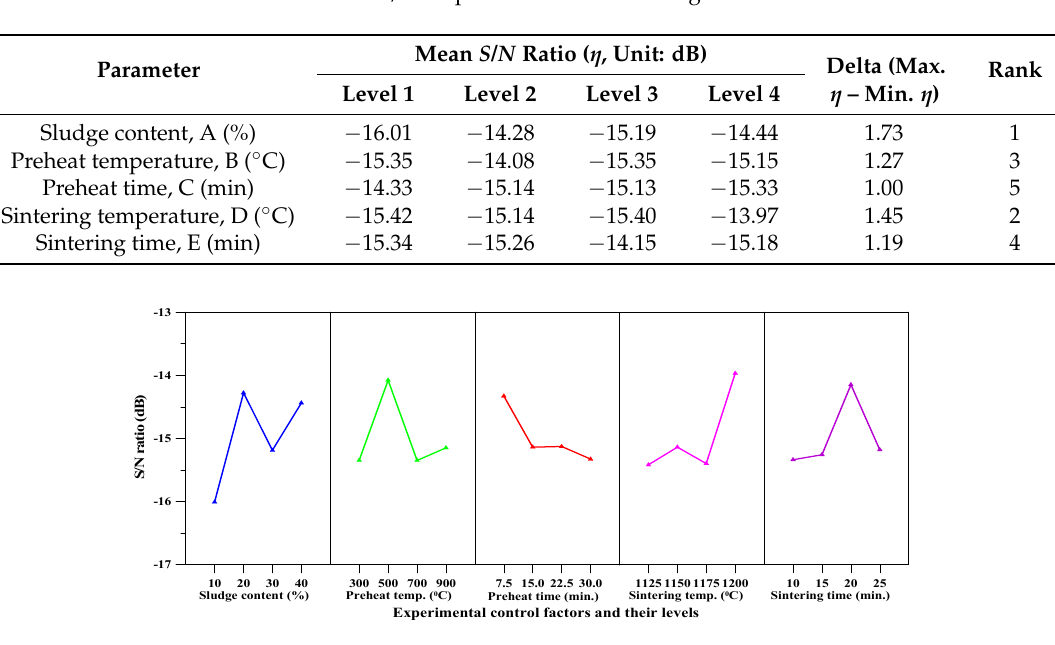
Table 11. Analysis of variance and F test for bloating ratio.